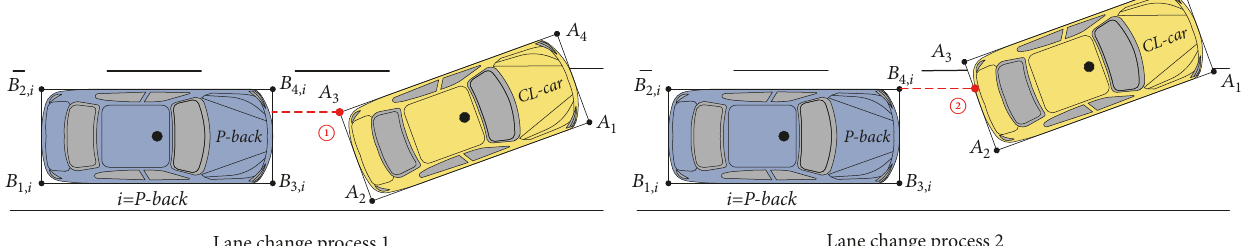
Figure 8: Potential angle collision point positions in different lane change processes between CL-car and P-back